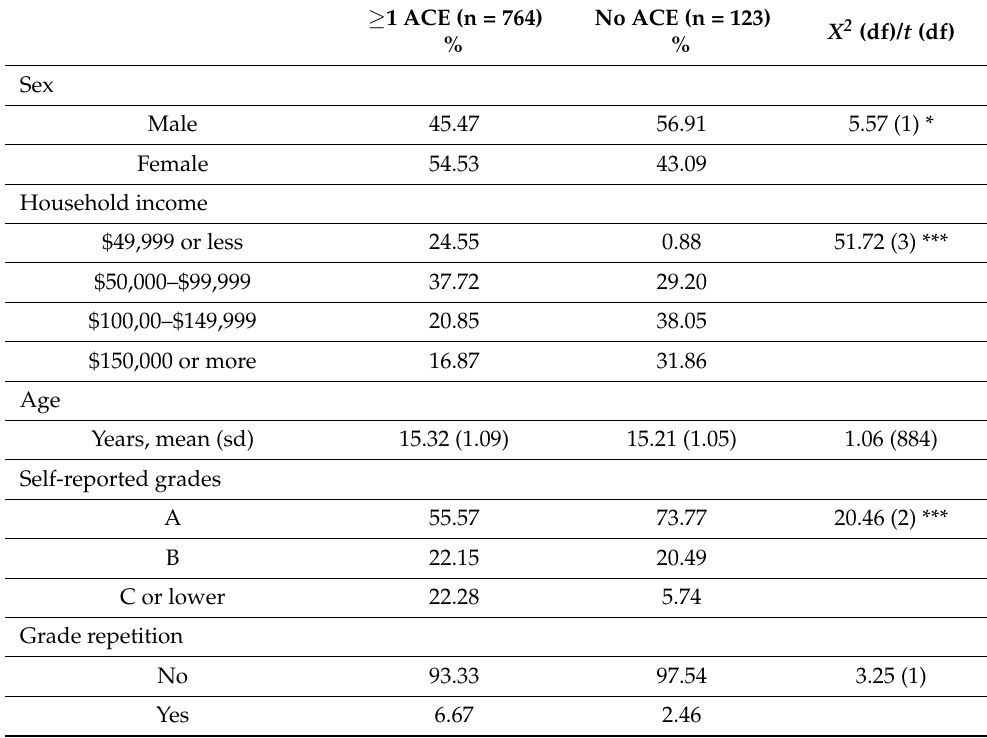
Table 1. Characteristics of adolescents with and without at least one